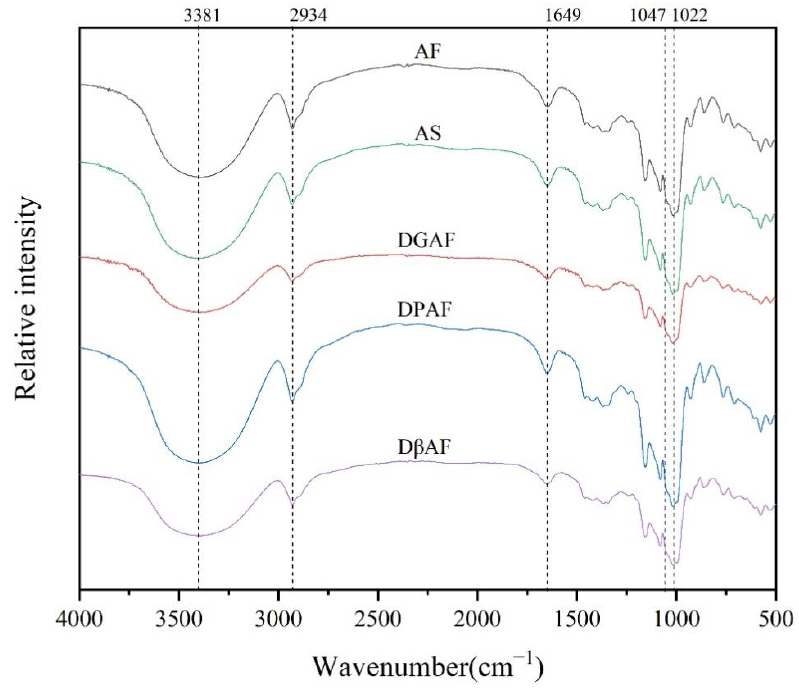
Figure 3. FT-IR spectra of AF and after removal of non-starch nutrients. AF, acorn flour; AS, acorn starch; DGAF, degreased acorn flour; DPAF, deproteinized acorn flour; D β AF, de- β -glucan acorn flour.